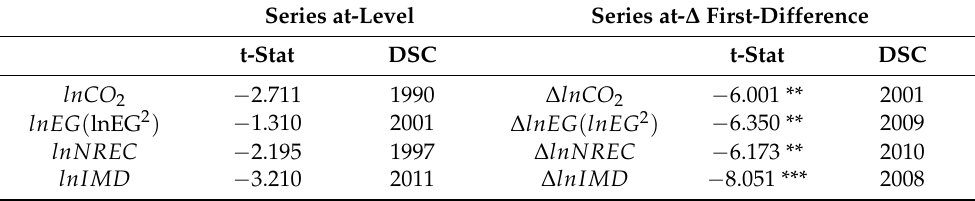
Table 1. Findings of the ZA test.